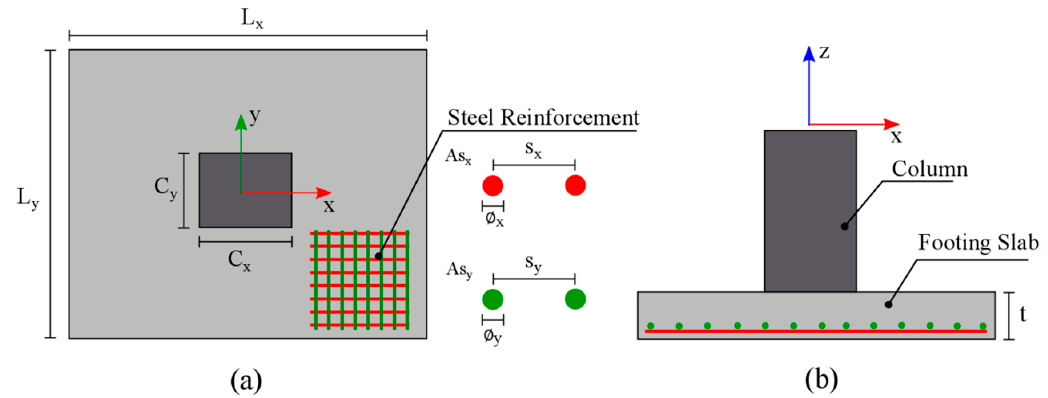
Figure 2. Rectangular footing and its decision variables: ( a ) plan view; ( b ) elevation.